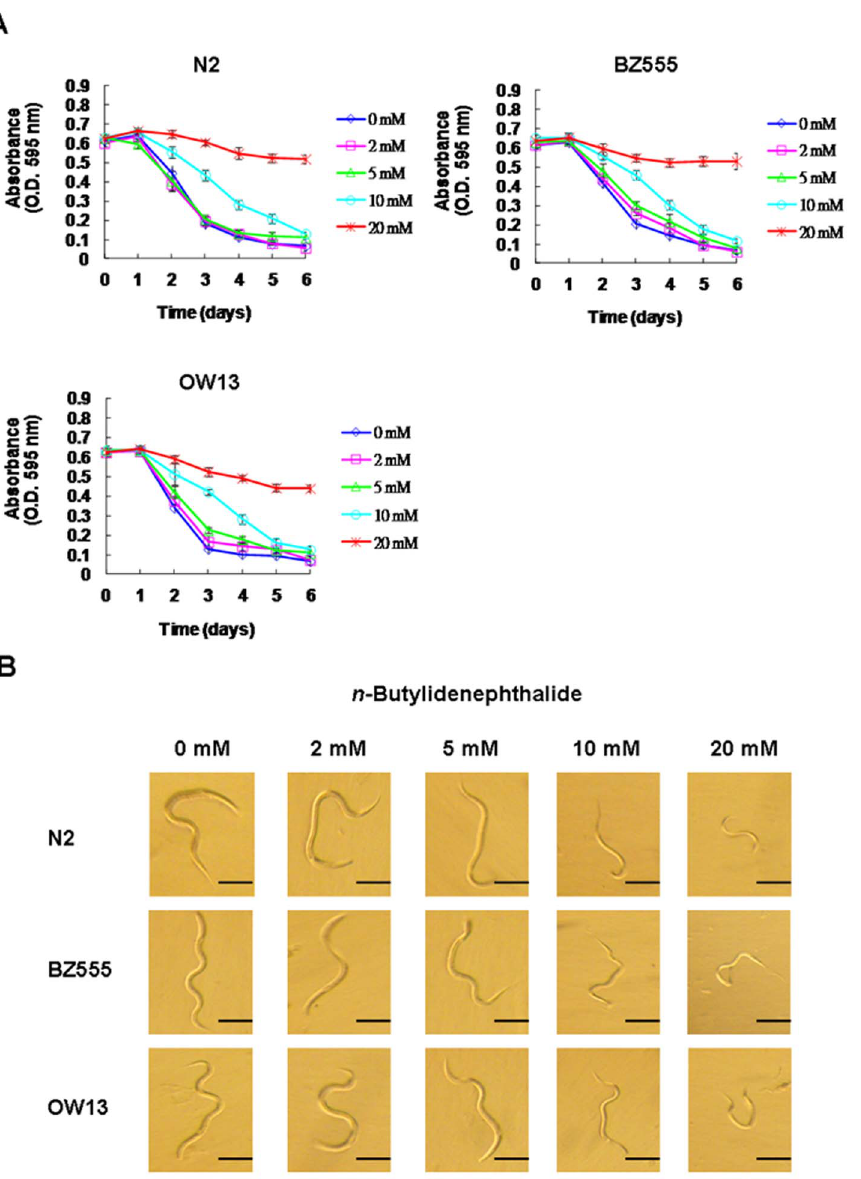
Figure 2. Concentration of n -butylidenephthalide for experimenting was determined with a food clearance assay. Between 20 and 30 newly hatched L1 synchronized animals of N2, BZ555 or OW13 were incubated in E. coli (OD A 595 =0.6) in a 96-well plate at 25 u C containing different n -butylidenephthalide concentrations to a total volume of 60 m L. The OD of the plate was measured daily for 6 days. Note the lower OD ( , 0.6) in a well due to the reduced path length of the 60 m L final suspension compared to the 1 cm path length in a spectrophotometer. (A) The OD of E. coli recorded daily for each concentration of n -butylidenephthalide. (B) Animals treated with no n -butylidenephthalide and the indicated n - butylidenephthalide concentrations. Animals treated with 10 mM n -butylidenephthalide were alive but concentrations over 20 mM caused death. Scale bar is 100 m m.